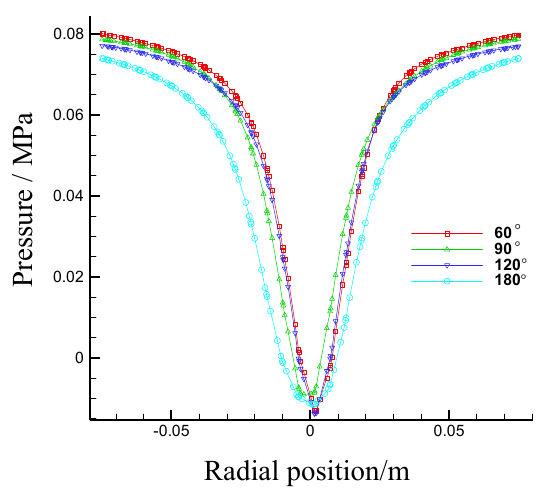
Figure 9. Pressure distribution of different cone angle hydrocyclone.